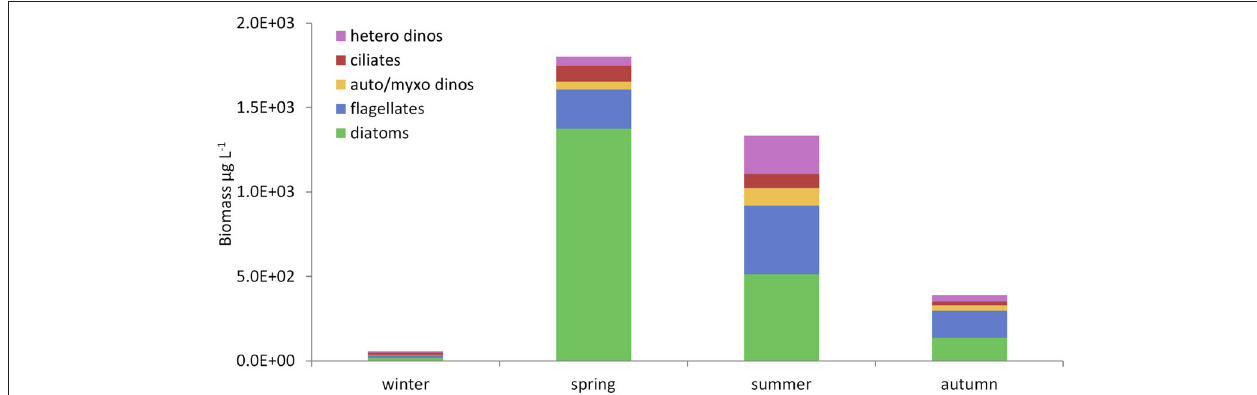
FIGURE 8 | Seasonal changes in microplankton composition in the WIS in 2008–2009. Mean bio-volumes ( µ g L − 1 ) of each functional microplankton group ( Table 4 ) in the seasons defined in Table 8 (drawn from Scherer, 2012). Hetero dinos, heterotrophic dinoflagellates; ciliates, oligotrophic ciliates; auto/myxo dinos, photoautotrophic and myxotrophic dinoflagellates; flagellates, micro-flagellates (all nutritional modes); diatoms, centric and pennate